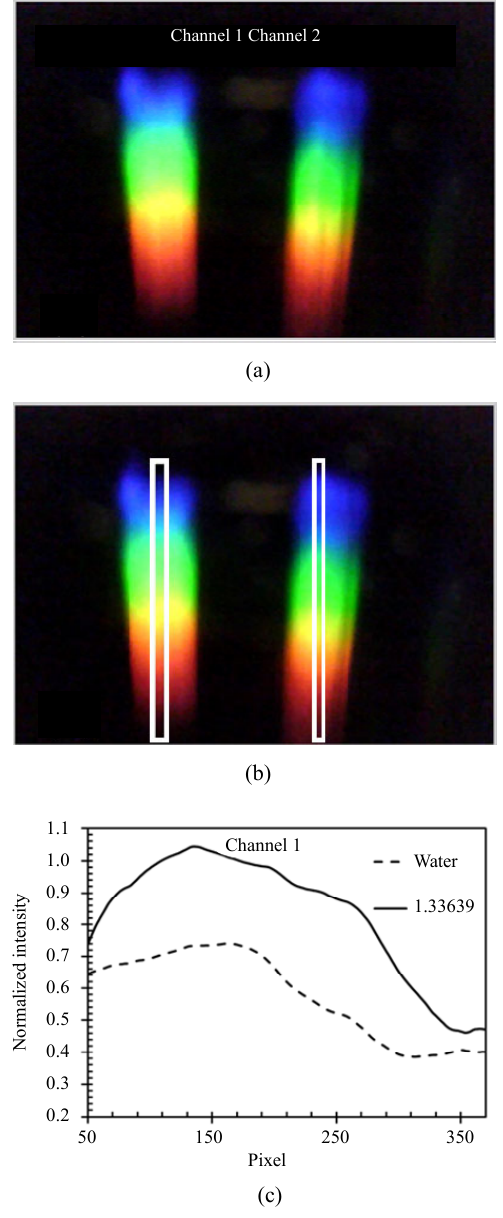
Fig. 13 Spectra captured by multi-channel spectrometer: (a) spectrum of Channels 1 and 2 at a distance apart (1.6 mm), (b) selection of area of interest for spectral analysis, and (c) change in intensity level for different RIs from Channel 1.